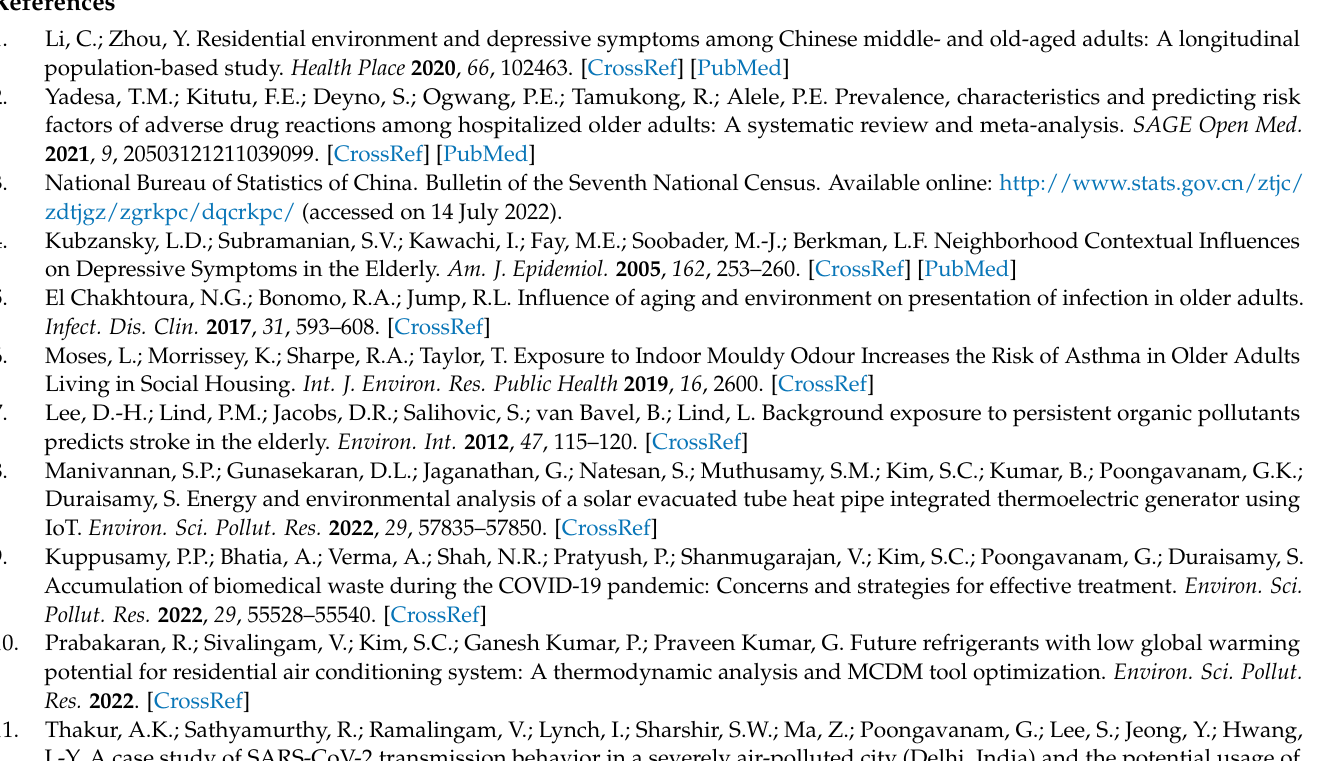
Figure A4. Indoor light intensity monitoring results. ( a ) Zuozi dwelling, ( b ) L-shape dwelling, ( c ) lower store and upper house dwelling, ( d ) front store and back house dwelling.